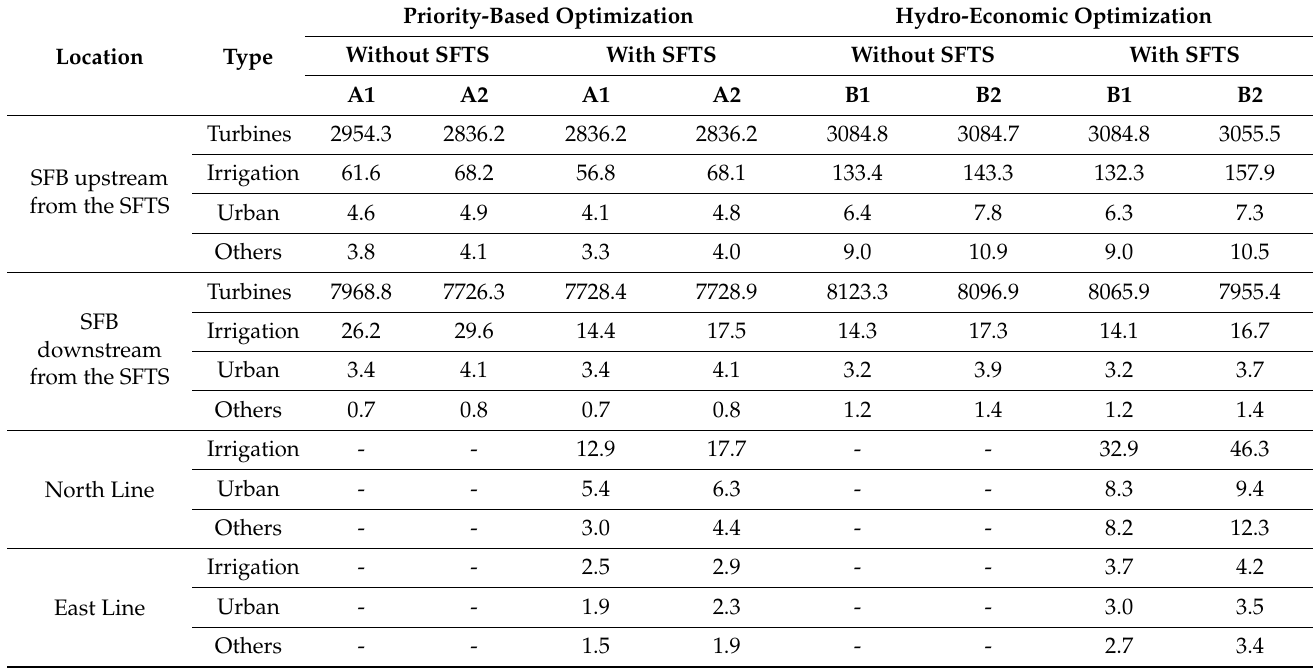
Table 2. Mean flow provided (m 3 · s − 1 ) for the 2020 (A1 and B1) and 2040 (A2 and B2) scenarios.